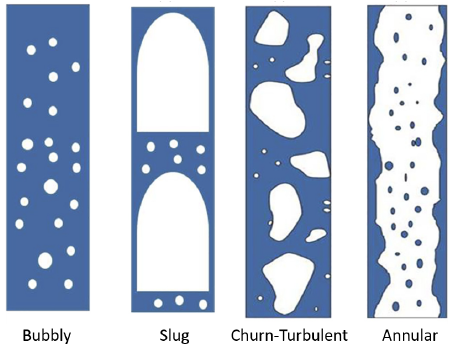
Figure 2. Representation of flow regimes in vertical pipes. Reprinted with permission from